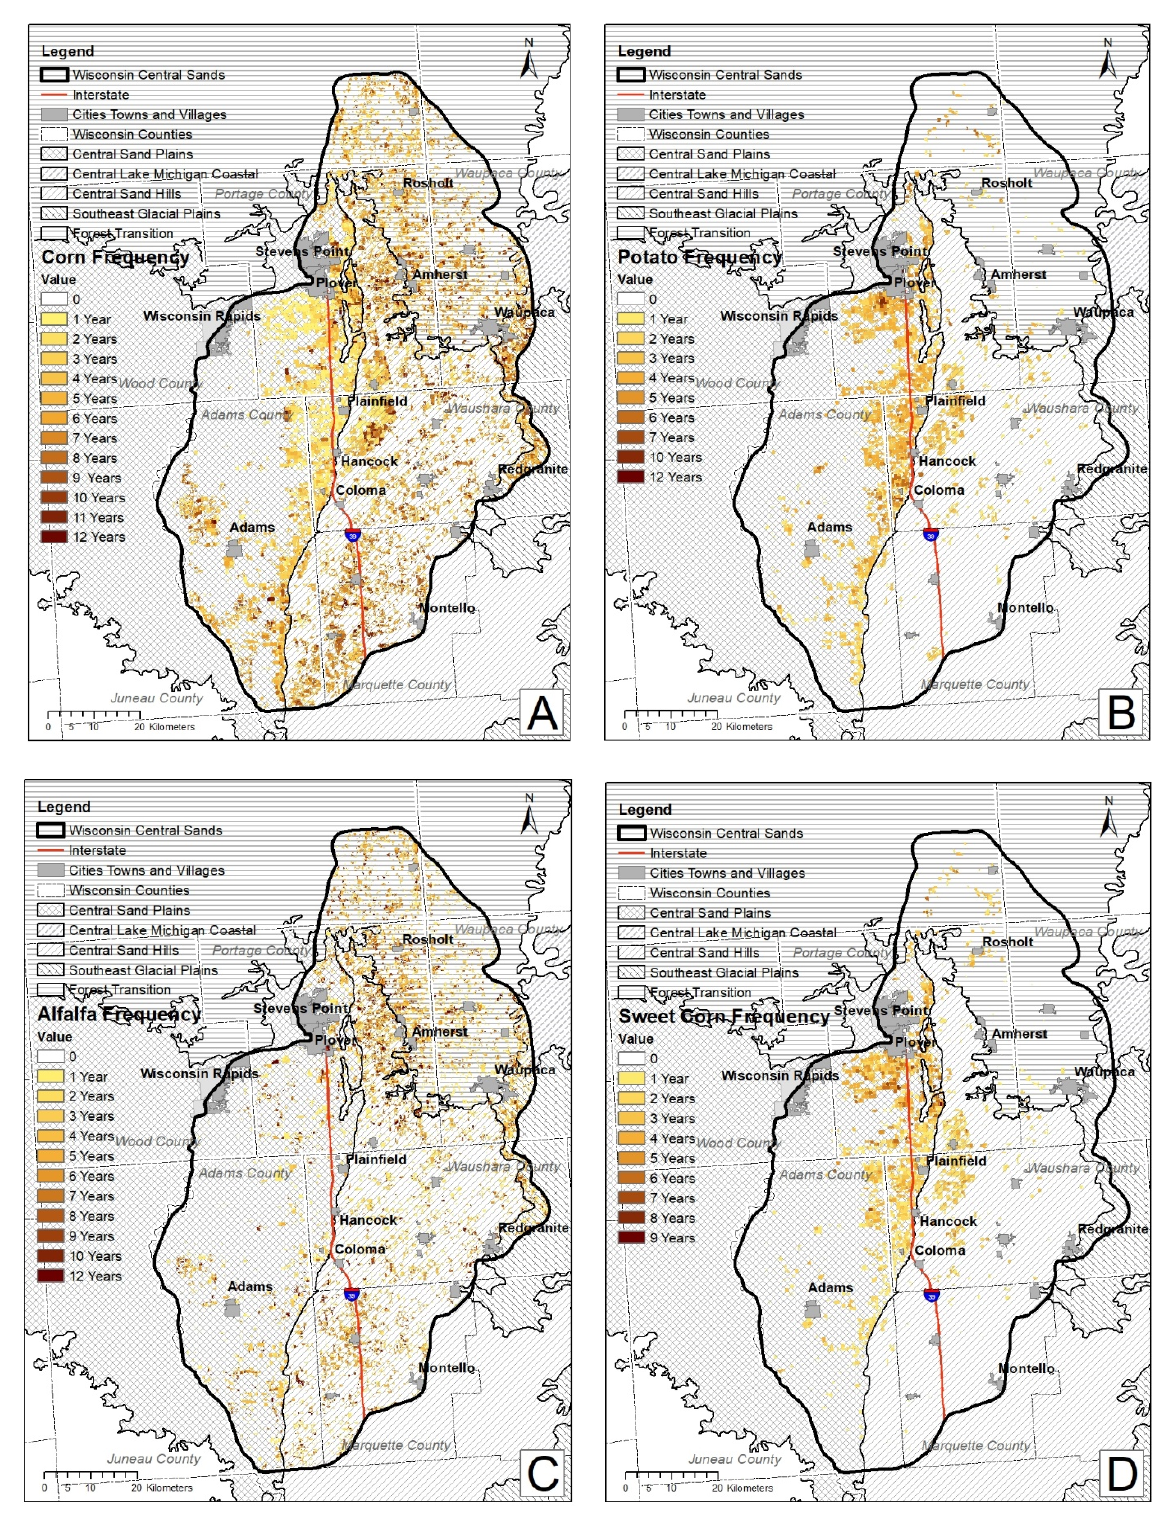
Figure 2. Frequency of crop plantings between 2008 and 2019 for ( A ) corn, ( B ) potato, ( C ) alfalfa, and ( D ) sweet corn. Sweet corn frequency totals were not adjusted for missing data in 2017 and 2018. The five ecological landscapes that are found within the WCS are shown.